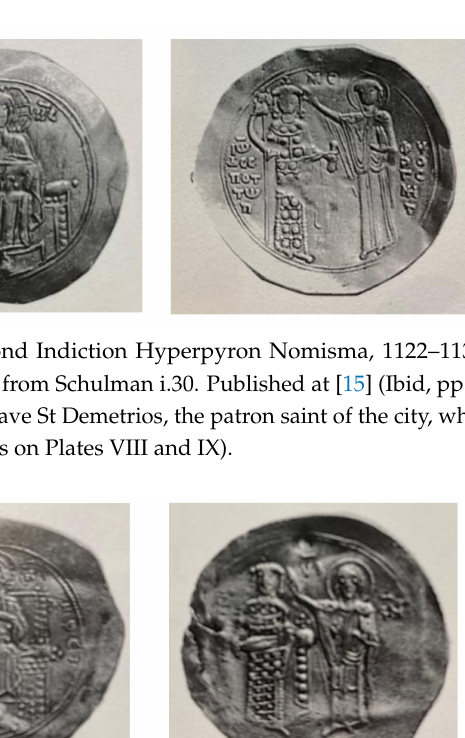
Figure 4. First Indiction Hyperpyron Nomisma, 1118–1122; impression on gold; New York; 1b.1. Whittemore Collection. Published at [15] ( DOC , pp. 256–259, 260–261. Images on Plate VIII).